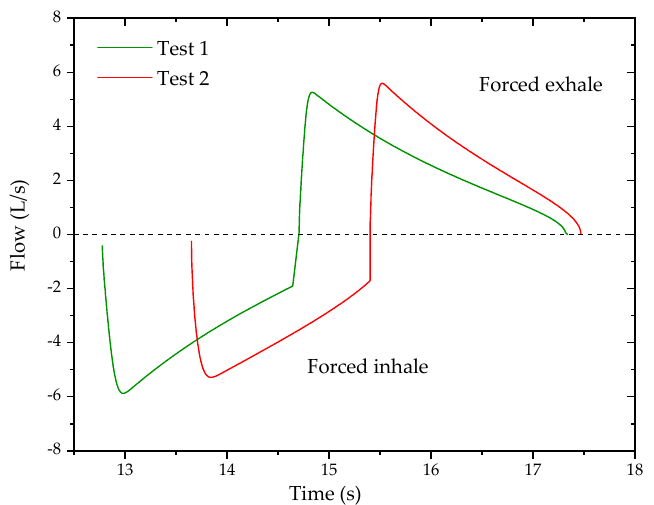
Figure 8. Forced breathing section of the flow–time curves obtained using the proposed sensing system.